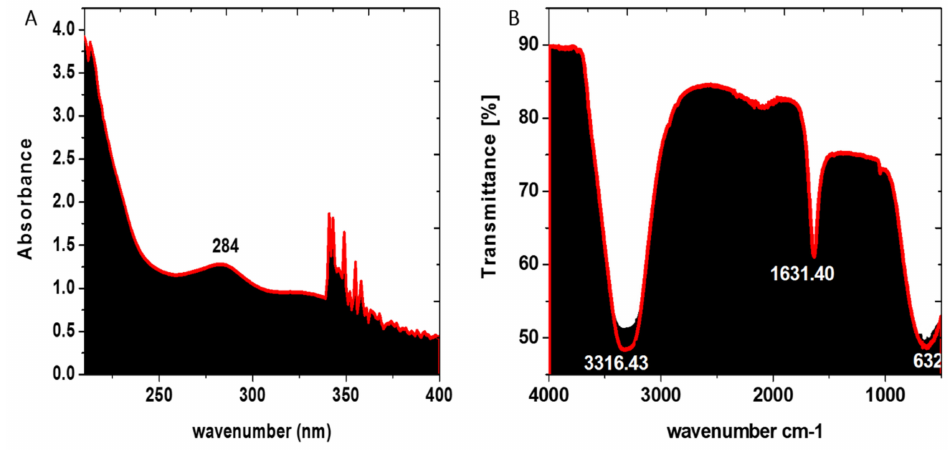
Figure 2. ( A ) UV-Vis spectroscopy of Enterobacter strain G52 extract mediated FeNPs and ( B ) FTIR spectra of Enterobacter strain G52 extract mediated FeNPs.